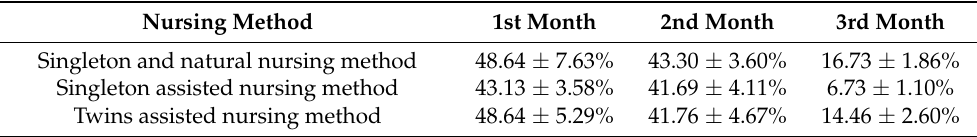
Figure 2. Comparison of the maternal behaviors of different experimental group pandas in the mother–cub period. Data were presented as the mean ± S.D. (standard deviation). NS (no significant difference). p > 0.05; ** p < 0.01. n = 8 per group. Table 3. Maternal behavioral observations of the different nursing methods of groups of captive giant panda mothers were performed on the 1st, 2nd and 3rd month of the mother–cub period. The data were presented as mean ± S.D (standard